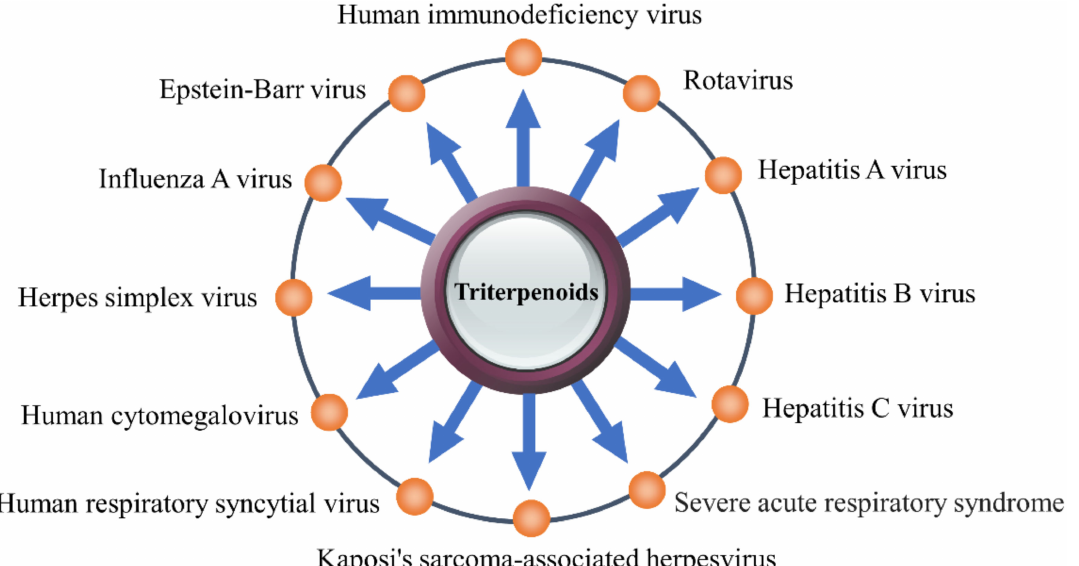
Figure 1. The triterpenoids have inhibitory effects on a variety of